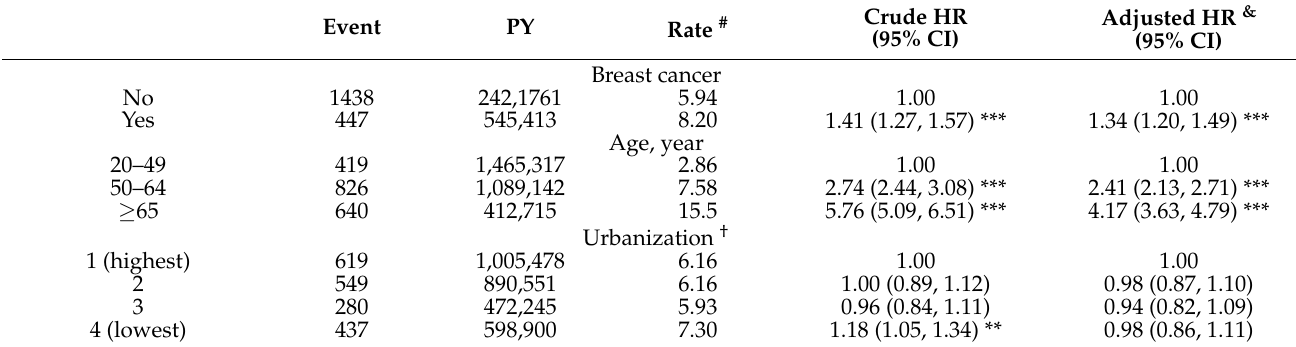
Figure 1. Cumulative incidence curves of lung cancer for the breast cancer and cancer-free healthy group. Table 2. The incidence and risk factors for lung